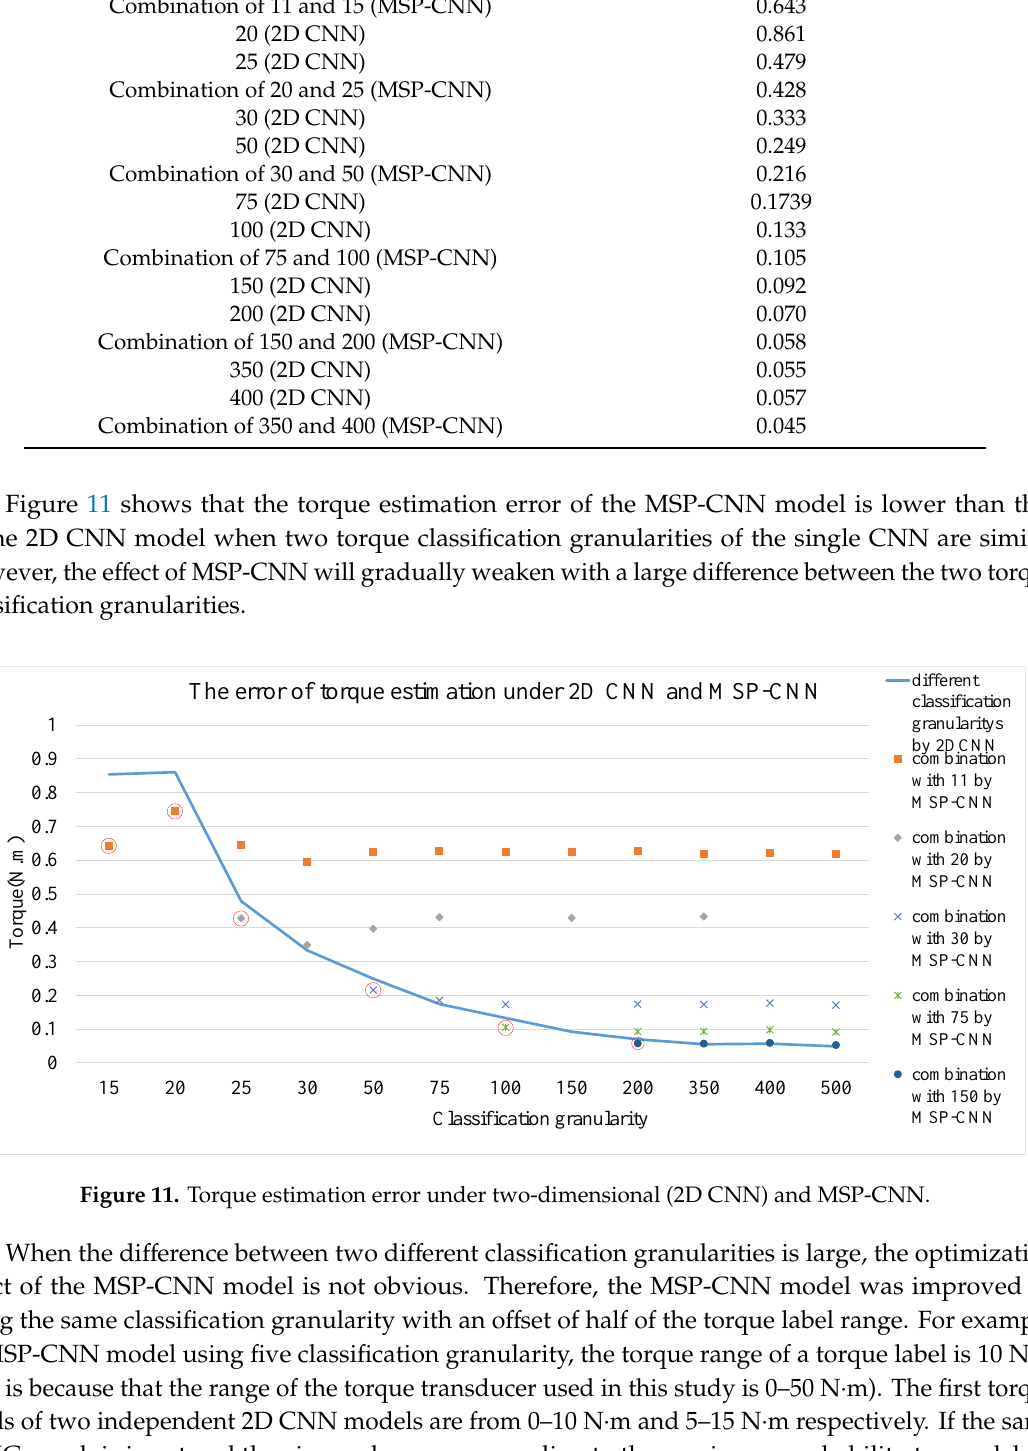
Table 4. Torque estimation errors by 2D CNN and MSP-CNN using the same classification granularity. Torque Classification Granularity